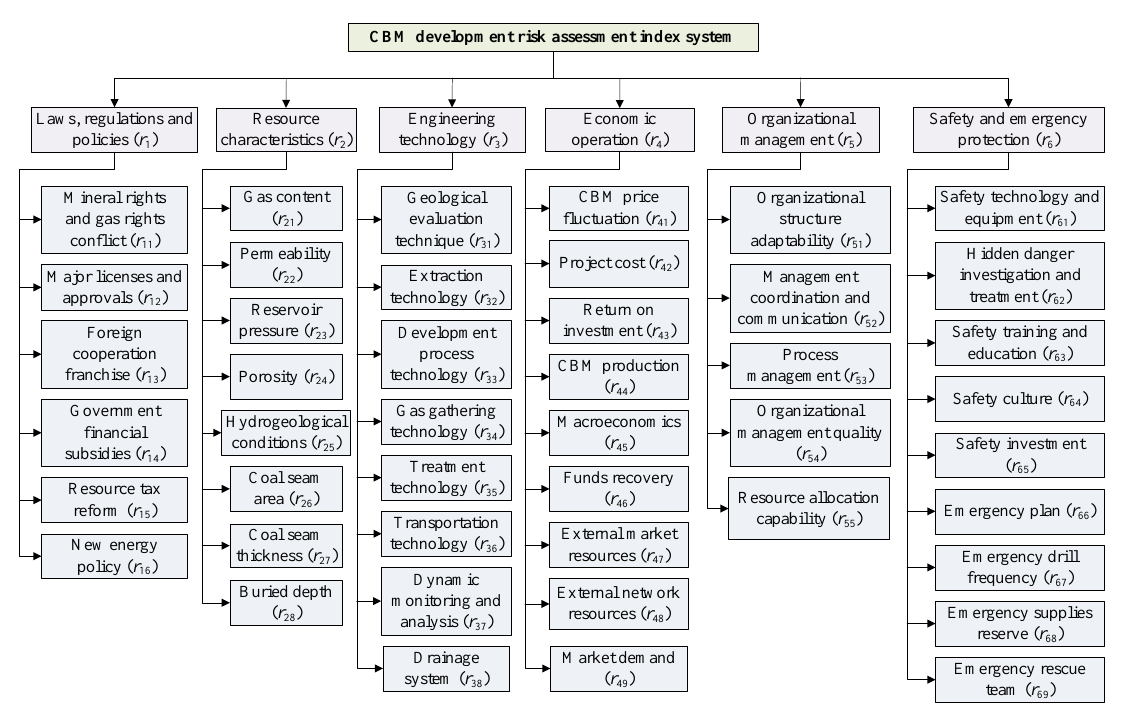
Figure 2. CBM development risk assessment index system.